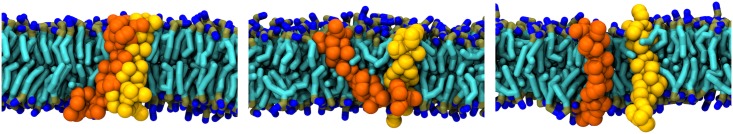
Selected snapshots of transmembrane domain dimerization.Examples of conformations at different COM–COM distances (from top to the bottom: 1.2, 2.0, and 2.4 nm) from the umbrella sampling simulations (COM stands for the center of mass). Here, the U-0.1 scaling method is employed (see below). Chains of lipids (DLPC) are shown in cyan, phosphate beads in brown, and choline beads in blue. Peptides (EphA1) are shown in yellow and orange. Water, antifreeze particles, and ions have been omitted from the images.